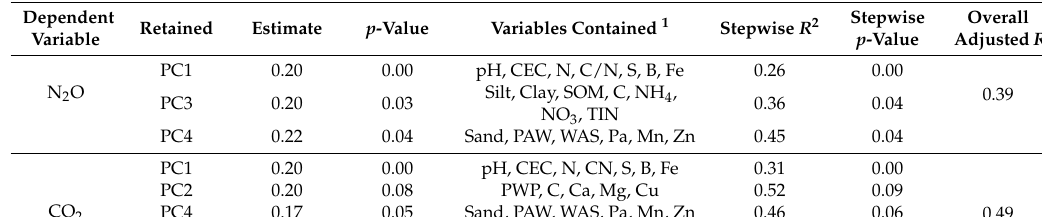
Table 5. Dependent variables are based on multiple regression analyses of principal components (PC) extracted with eigenvalues >1 and retained in the model (significance level = 0.1500). Dependent variables (nitrous oxide, N 2 O; carbon dioxide, CO 2 ; methane, CH 4 ; yield index YdI) were modeled using both datasets (PCs are separated by either the 32 or the 52 observation datasets). Variables contained within each PC have component correlation scores (eigenvalues) with loadings greater than |0.25|. Overall adjusted R 2 values represent the amount of variation explained by the regression analysis. Principal Components Summary Using 32 (for GHG) and 34 (for YdL)